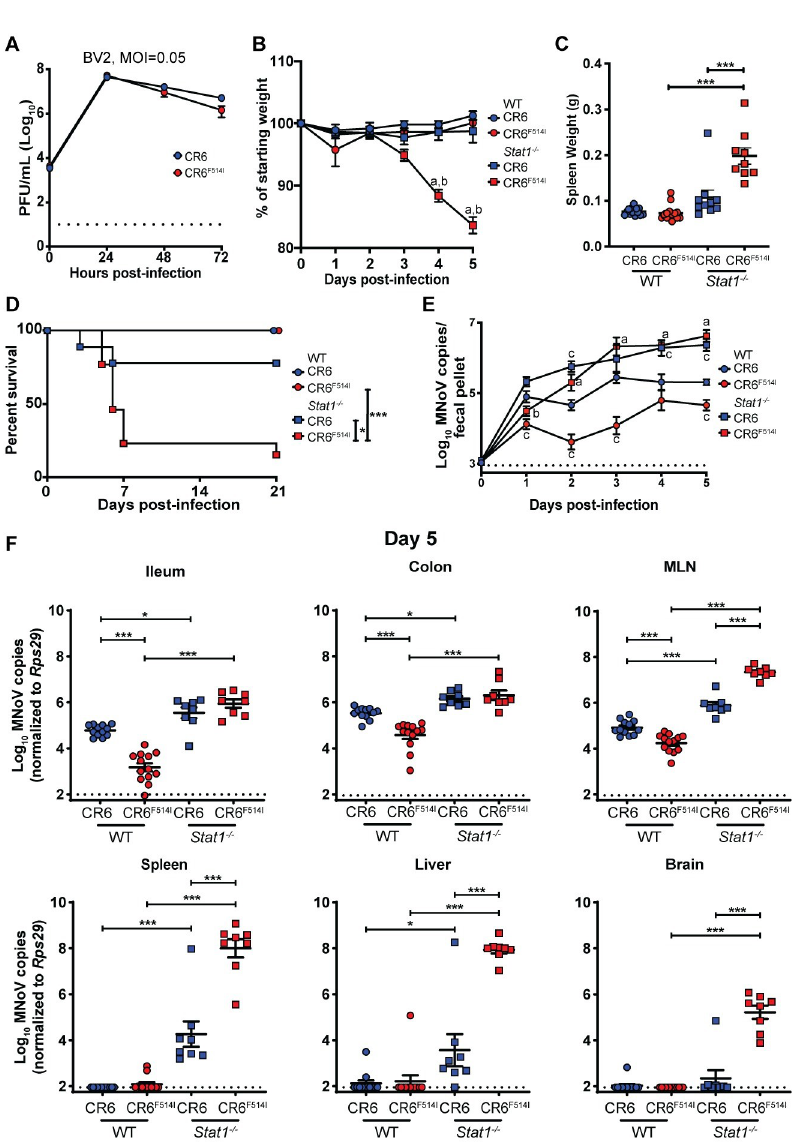
Fig 3. VP1 F514I is sufficient to confer lethality to Stat1 -/- mice. (A) Growth curves of CR6 and CR6 F514I in BV2 cells over 72 hpi, inoculated at an MOI of 0.05. Results combined from two independent experiments, analyzed by repeated-measures two-way ANOVA. (B-F) WT or Stat1 -/- mice were orally inoculated with 10 6 PFU of CR6 or CR6 F514I , and analyzed for weight loss to 5 dpi (B) , spleen weights at 5 dpi (C) , survival to 21 dpi (D) , stool viral levels to 5 dpi (E) , and tissue viral levels at 5 dpi (F) . N = 8–13 mice per group combined from at least two independent experiments. Weight loss (B) was analyzed by repeated-measures two-way ANOVA followed by Tukey’s multiple- comparison test. Survival (D) was analyzed by log-rank (Mantel-Cox) test. Stool virus levels (E) were analyzed by mixed-effects analysis followed by Tukey’s multiple-comparison test. Spleen weights (C) and tissue viral levels (F) were analyzed by ordinary two-way ANOVA followed by Tukey’s multiple comparisons test. Dashed lines indicate limit of detection for assays. For panels (B) and (E) , letters indicate that the data point which they are next to have a statistically significant difference of P < 0.05 in comparison to: a) WT + CR6 F514I ; b) Stat1 -/- + CR6; c) WT + CR6. Data shown as mean +/- SEM. ��� , P < 0.001; �� , P < 0.01; � , P < 0.05; ns, not significant. F514I amino acid change, and found that in one of three mice analyzed, the T6595A mutation (amino acid change F514I) was present in 21 dpi colon and liver tissues ( Fig 4C ). In light of this observation, we speculated that a single CR6-infected Stat1 -/- mouse sacrificed at day 5